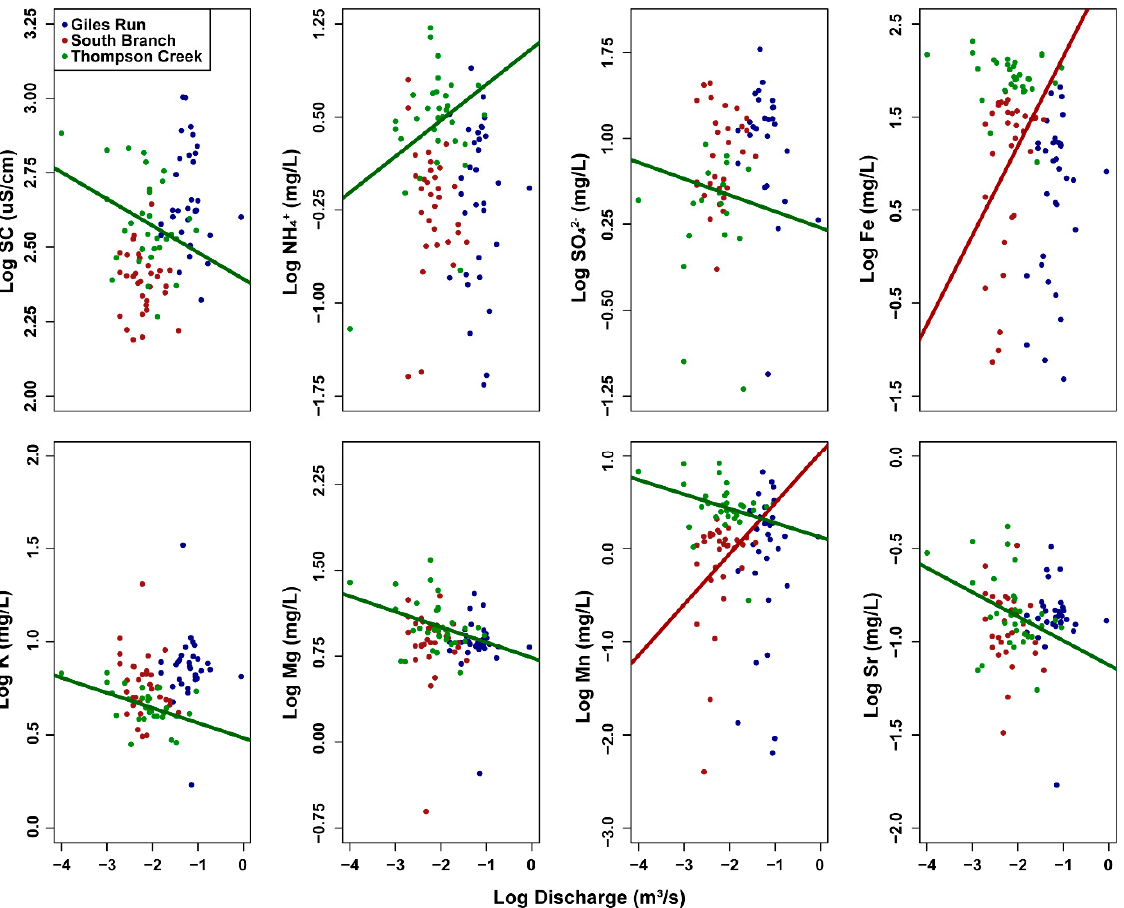
Figure 5. Log [concentration]—log [discharge] plots of selected subsurface water variables for Giles Run (blue), South Branch (red), and Thompson Creek (green). Regression lines of best fit included when the relationship was significant at p < 0.05. Plots are only shown when at least one stream had a C–Q relationship with a slope significantly different from 0. See Figure S2 for C–Q plots of all variables.